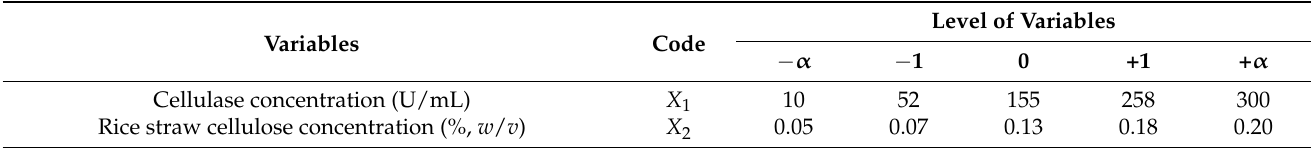
Table 1. Codes and actual levels of each variable of the central composite design.